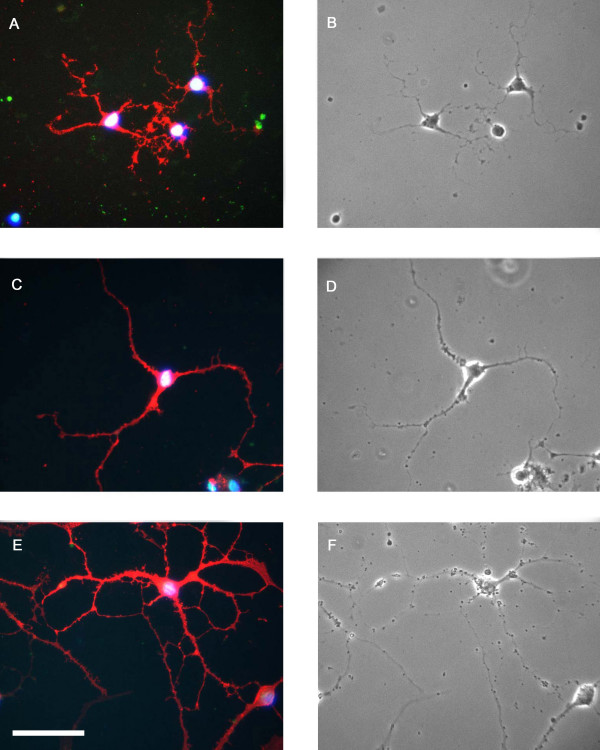
Morphology of cultured adult rat RGCs. The cells, cultured for 3 (A & B), 7 (C & D), and 11 (E & F) days, were labeled with anti-Thy-1 antibody (red) and DAPI nuclear stain (blue). (B), (D), are (F) are the corresponding phase-contrast images. Scale bar = 50 μm.